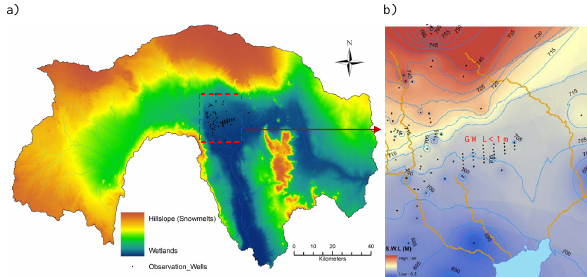
Figure 4. (a) Wetland–hillslope (snowmelt) hydrological system. (b) Shallow groundwater observation wells with mean surface wa- ter levels (0.3–40m) in the lower catchments of the upper Pangani River basin for the period